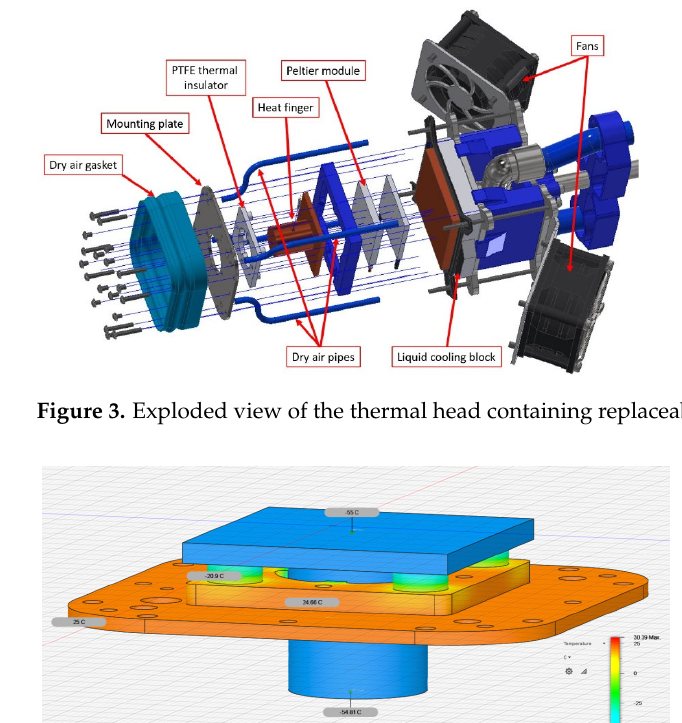
Figure 3. Exploded view of the thermal head containing replaceable “heat finger”.